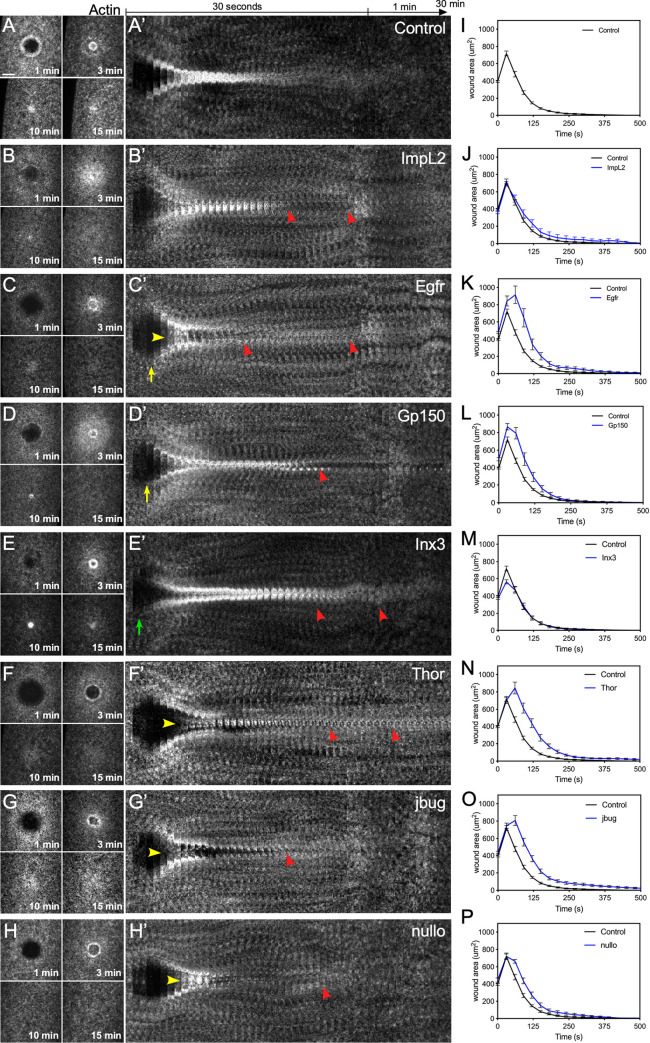
Knockdown of up-regulated genes results in wound over-expansion and abnormal actin dynamics.(A-H) Confocal XY projections of actin dynamics at 1, 3, 10, and 15 mpw from Drosophila NC4-6 embryos coexpressing sGMCA and a UAS-RNAi transgene during cell wound repair for control (w1118/+; sGMCA, 7063/+) (A), ImpL2RNAi/+; sGMCA, 7063/+ (B), EGFRRNAi/+; sGMCA, 7063/+ (C), Gp150RNAi/sGMCA, 7063 (D), Inx3RNAi/sGMCA, 7063 (E), ThorRNAi/sGMCA, 7063 (F), JbugRNAi/sGMCA, 7063 (G), NulloRNAi/sGMCA, 7063 (H). (A’-H’) XY kymographs across the wound areas depicted in (A-H), respectively. Note wound overexpansion (yellow arrows), wound underexpansion (green arrows), internal actin accumulation (yellow arrowhead), and remodeling defect/open wound (red arrowhead). (I-P) Quantification of wound area over time for (A-H’), respectively. Error bars represent ± SEM; n ≥ 10. See S3 Table for numerical data. Scale bars: 20 μm.